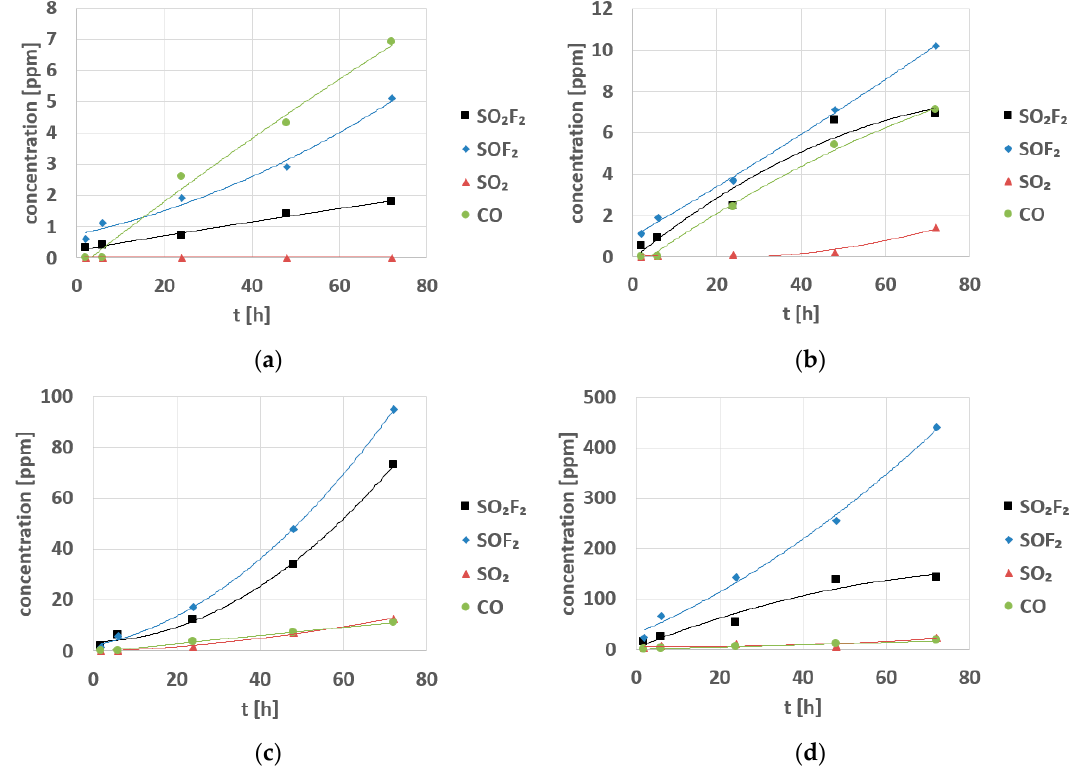
Figure 4. Concentrations of SO 2 F 2 , SOF 2 , SO 2 , CO of ( a ) 100 pC, ( b ) 1000 pC, ( c ) 3000 pC, and ( d ) 10,000 pC.